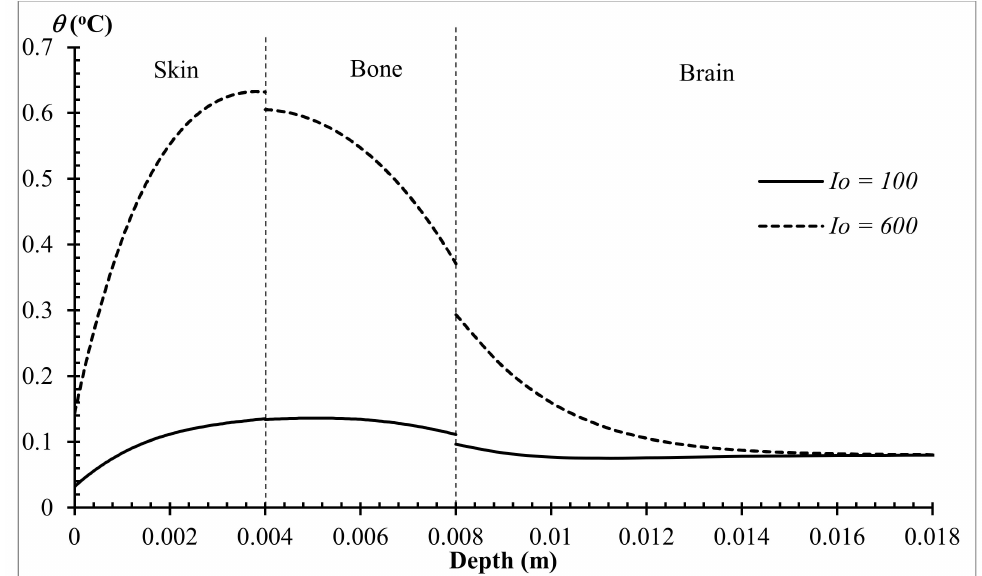
Figure 14. The dynamical temperature increment with various power densities on an adult’s head.